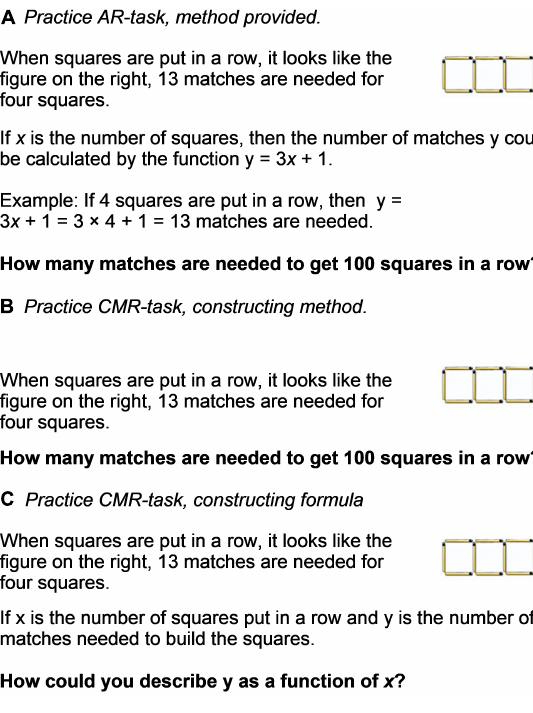
FIGURE 1 | Examples of AR and CMR practice tasks and how they were presented to the students on their laptop screen. (A) AR practice task; (B) CMR tasks practice task; (C) CMR task asking for the